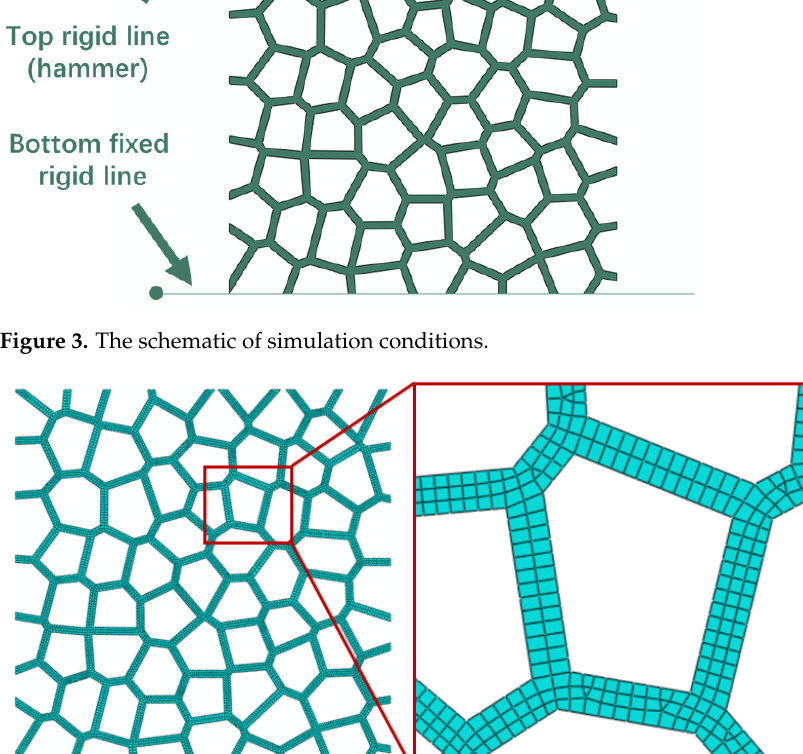
Figure 4. Models with 73.0% porosity corresponded to element sizes of 0.07 mm after meshing.